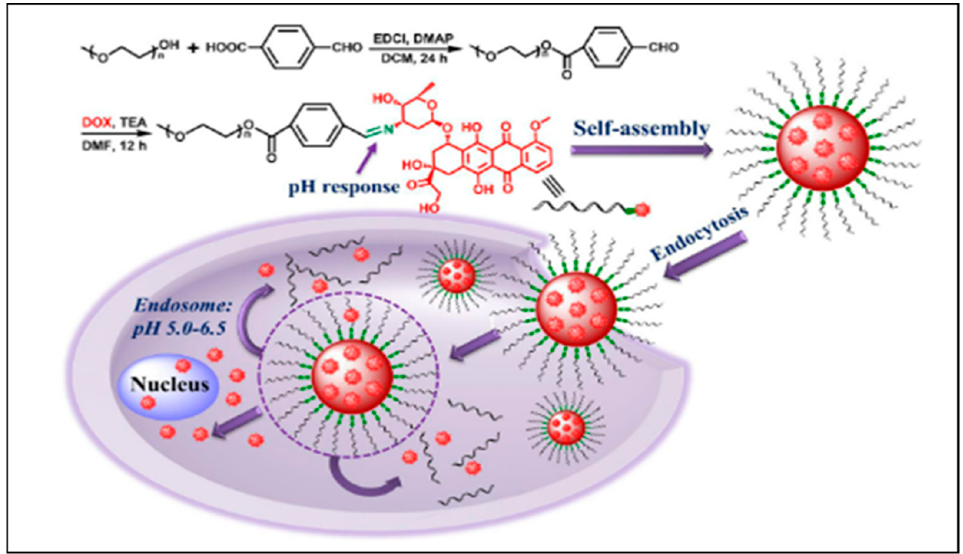
Figure 2. Illustration of self-assembled polymer PEG-Schiff nanoparticles and DOX drug delivery using pH sensitive conjugate PEG-Schiff-DOX. (Reproduced from Ref. [45] with permission from Frontiers.)